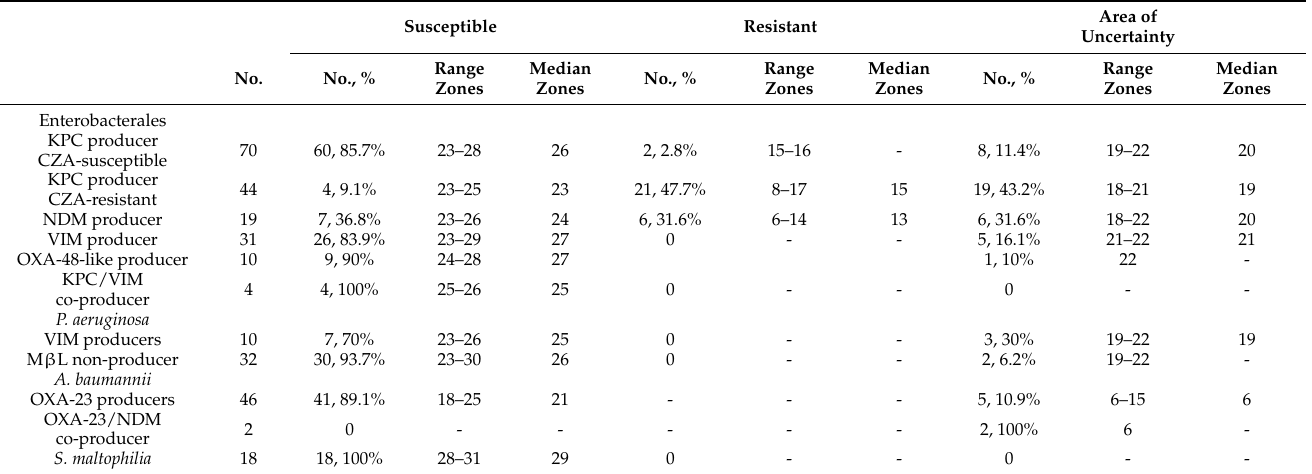
Table 1. Cefiderocol activity by disc diffusion against multidrug-resistant Gram-negative isolates included in the study